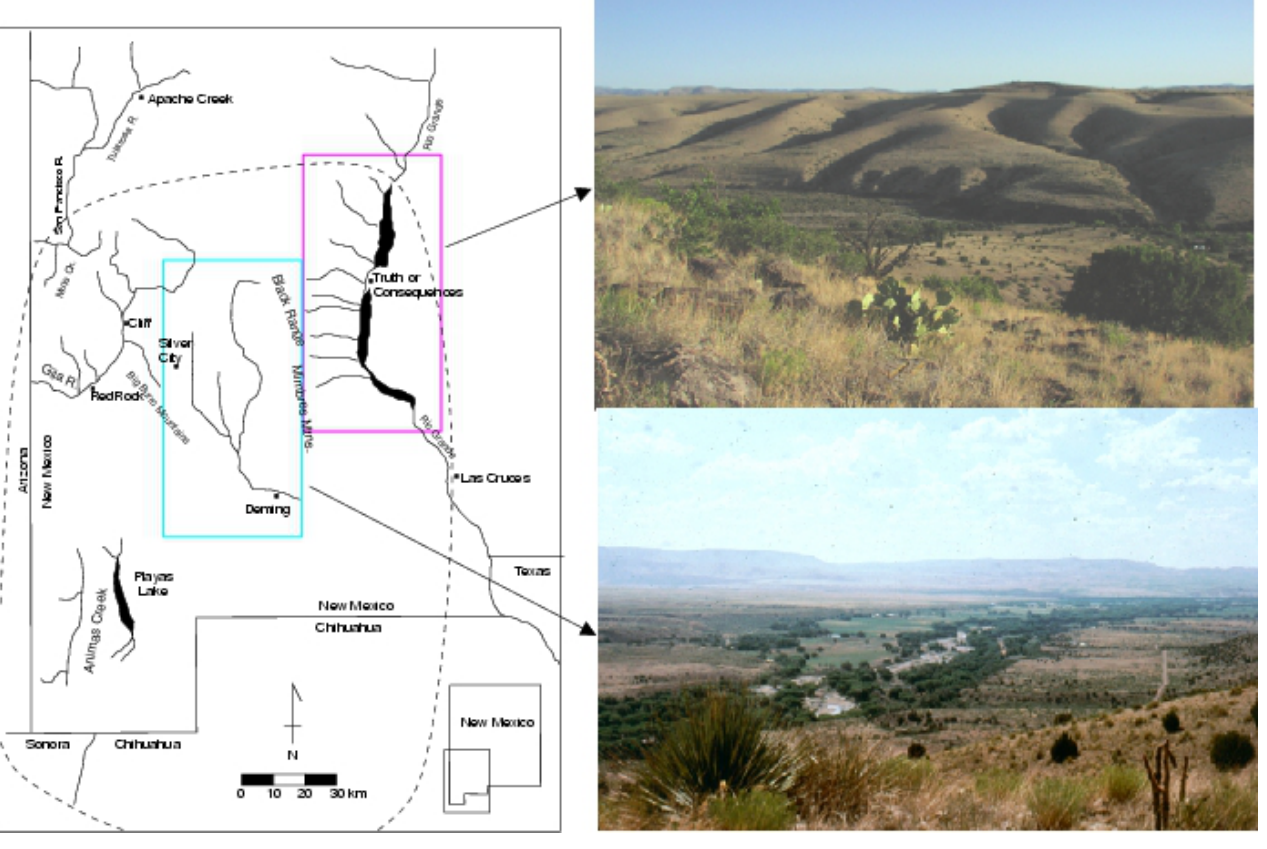
Fig. 1 . The Mimbres region. Turquoise and magenta rectangles indicate the Mimbres Valley and eastern Mimbres area,